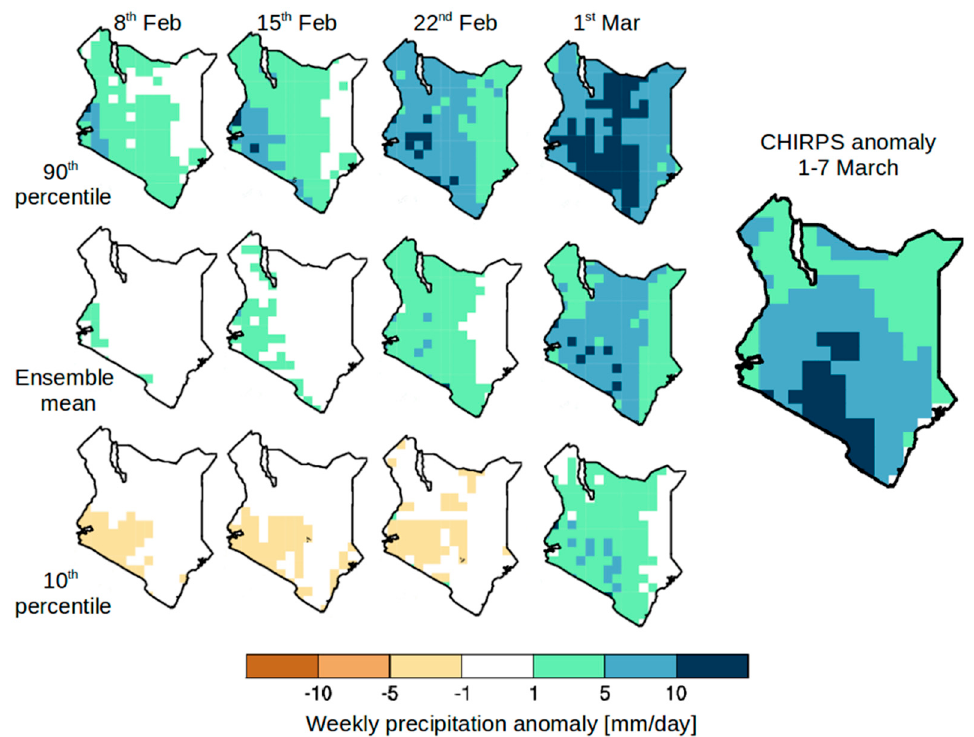
Figure 12. Forecast of weekly averaged precipitation anomaly (top to bottom: the ensemble 90 th percentile, mean, and 10 th percentile) from the ECWMF extended-range system, for forecasts of the week 1–7 March, issued one to four weeks ahead (columns left to right). The observed CHIRPS rainfall anomaly is shown the right.